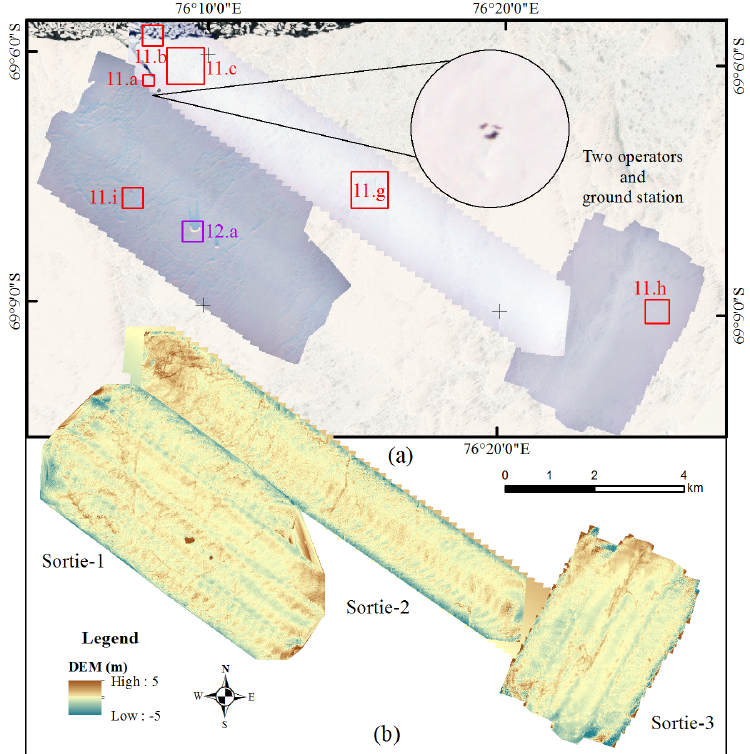
Figure 4. The standard products of the structure from motion (SfM) software, exported from Agisoft R (cid:13) PhotoScan v1.2.4: ( a ) The mosaic images after ortho-rectification. The darker tone in the sortie-1 orthomosaic is due to the lower solar altitude angle, as compared with that of sortie-2 and sortie-3. The circular close-up shows two operators and the ground station in a flat area 400 m ahead of the R/V Xuelong. See Figure 2b,c for the in-situ environment. ( b ) The digital surface models (DSM) of three sortie projects. Note that systematic biases include the slight ‘doom effect’ and high frequency jitters along the flight course. Please refer to Figure 1c for their respective flight courses and geographic